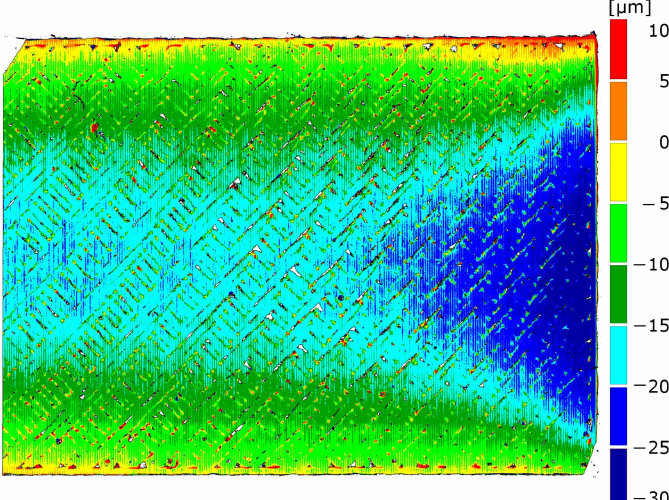
Figure 11. Surface error of final scanned ABS part to best fit CAD using Alicona scan data. The surface finish of the SiC part was next analyzed before and after machining.